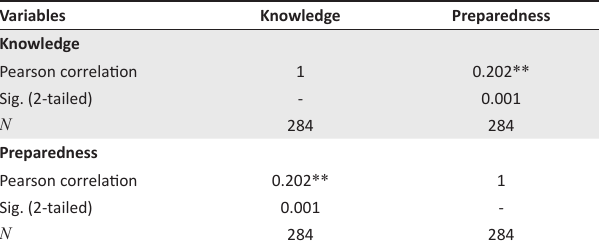
TABLE 7: Analysis of the relationship between knowledge and preparedness.